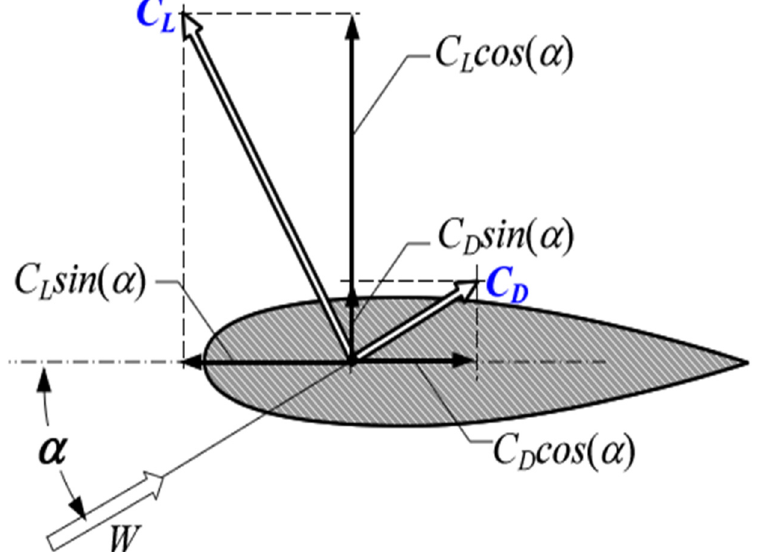
Figure 8. Aerodynamic coefficients acting on a Darrieus WT blade element